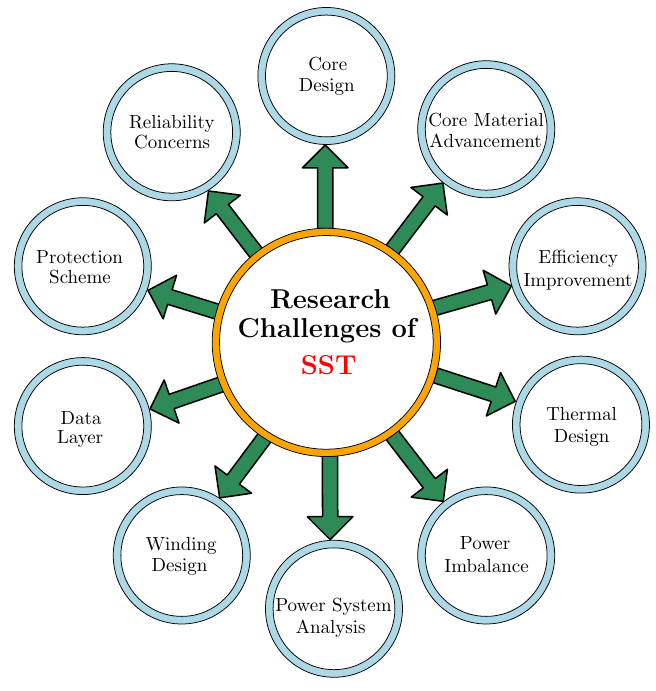
Figure 9. Research challenges of